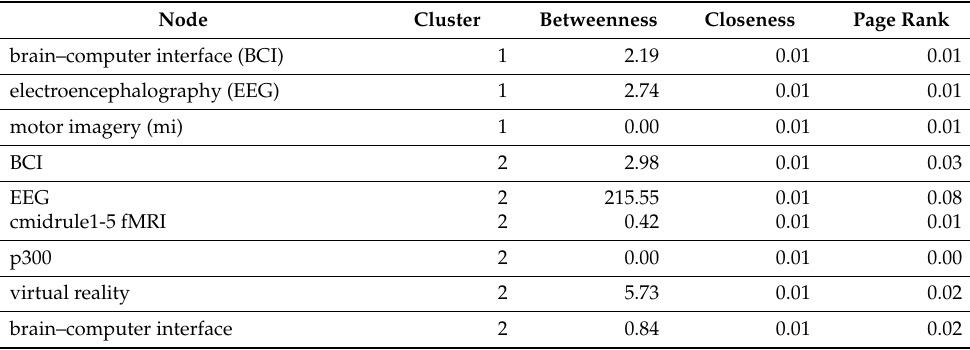
Table 5. Cluster analysis based on author’s keyword